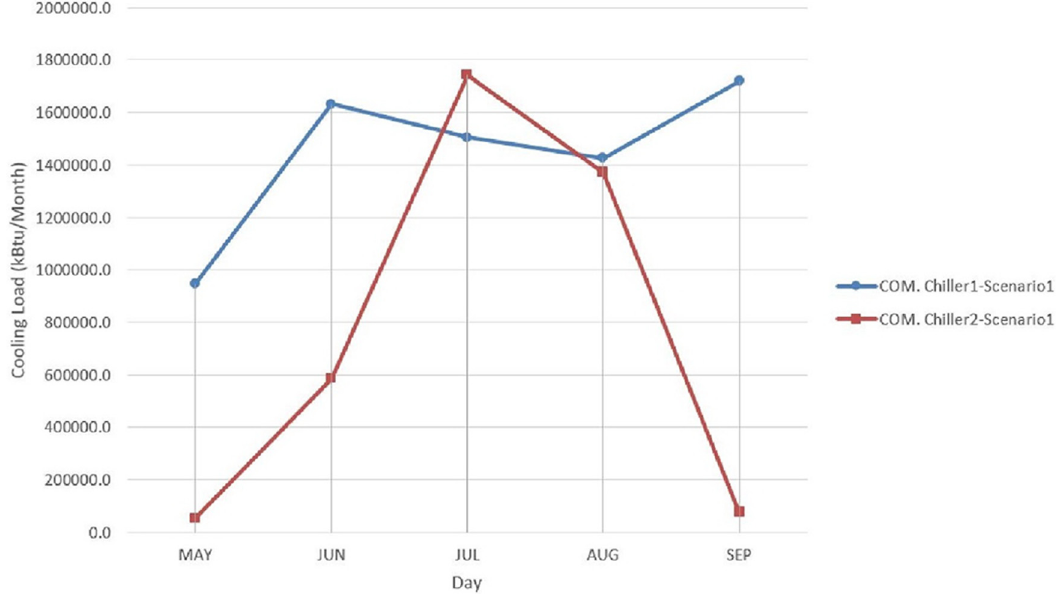
Fig. 6. The amount of cooling load provided by screw vapor compression chillers (scenario 1).